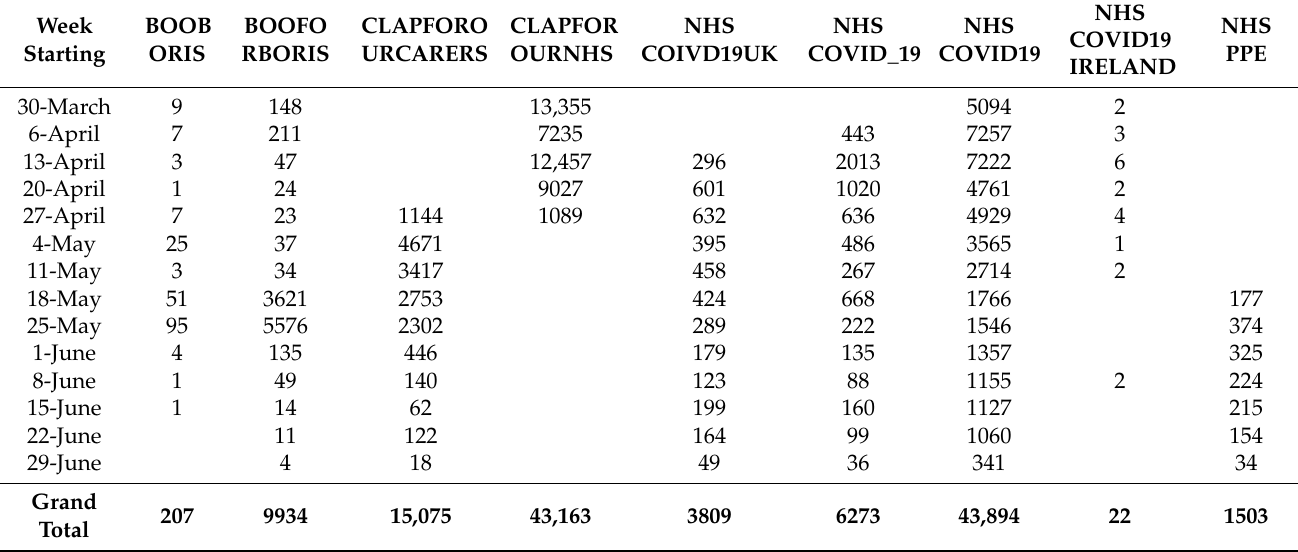
Table 1. Tweets per week by